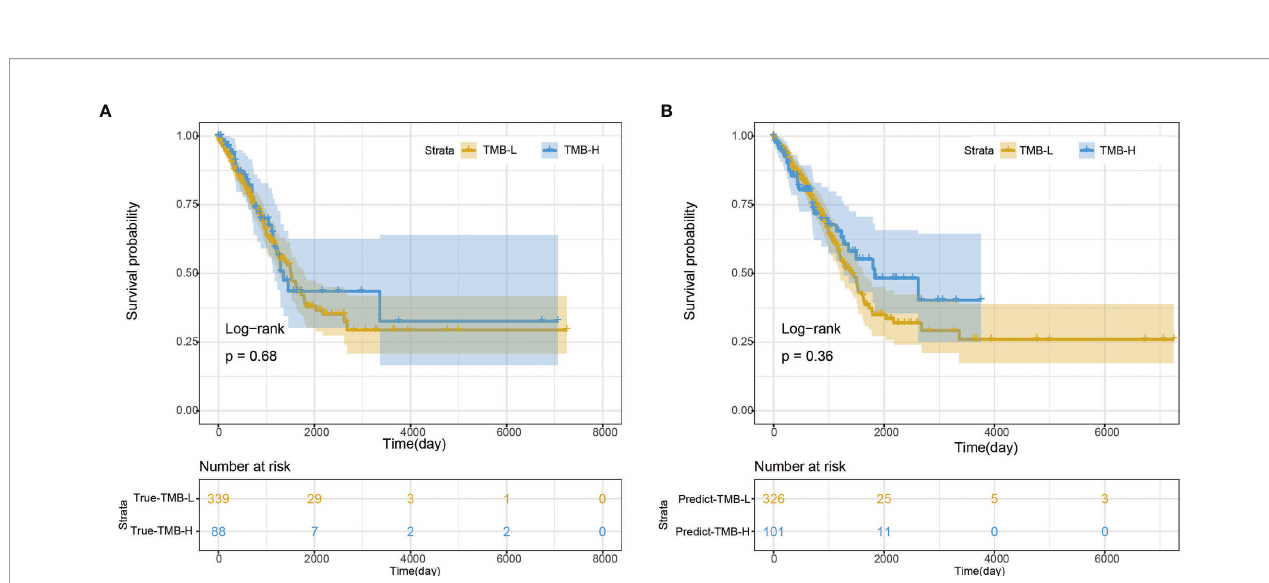
FIGURE 6 | Survival analysis. (A) Survival analysis based on the true clinical data. (B) Survival analysis based on the predict result of TMB status by H&E-stained histological